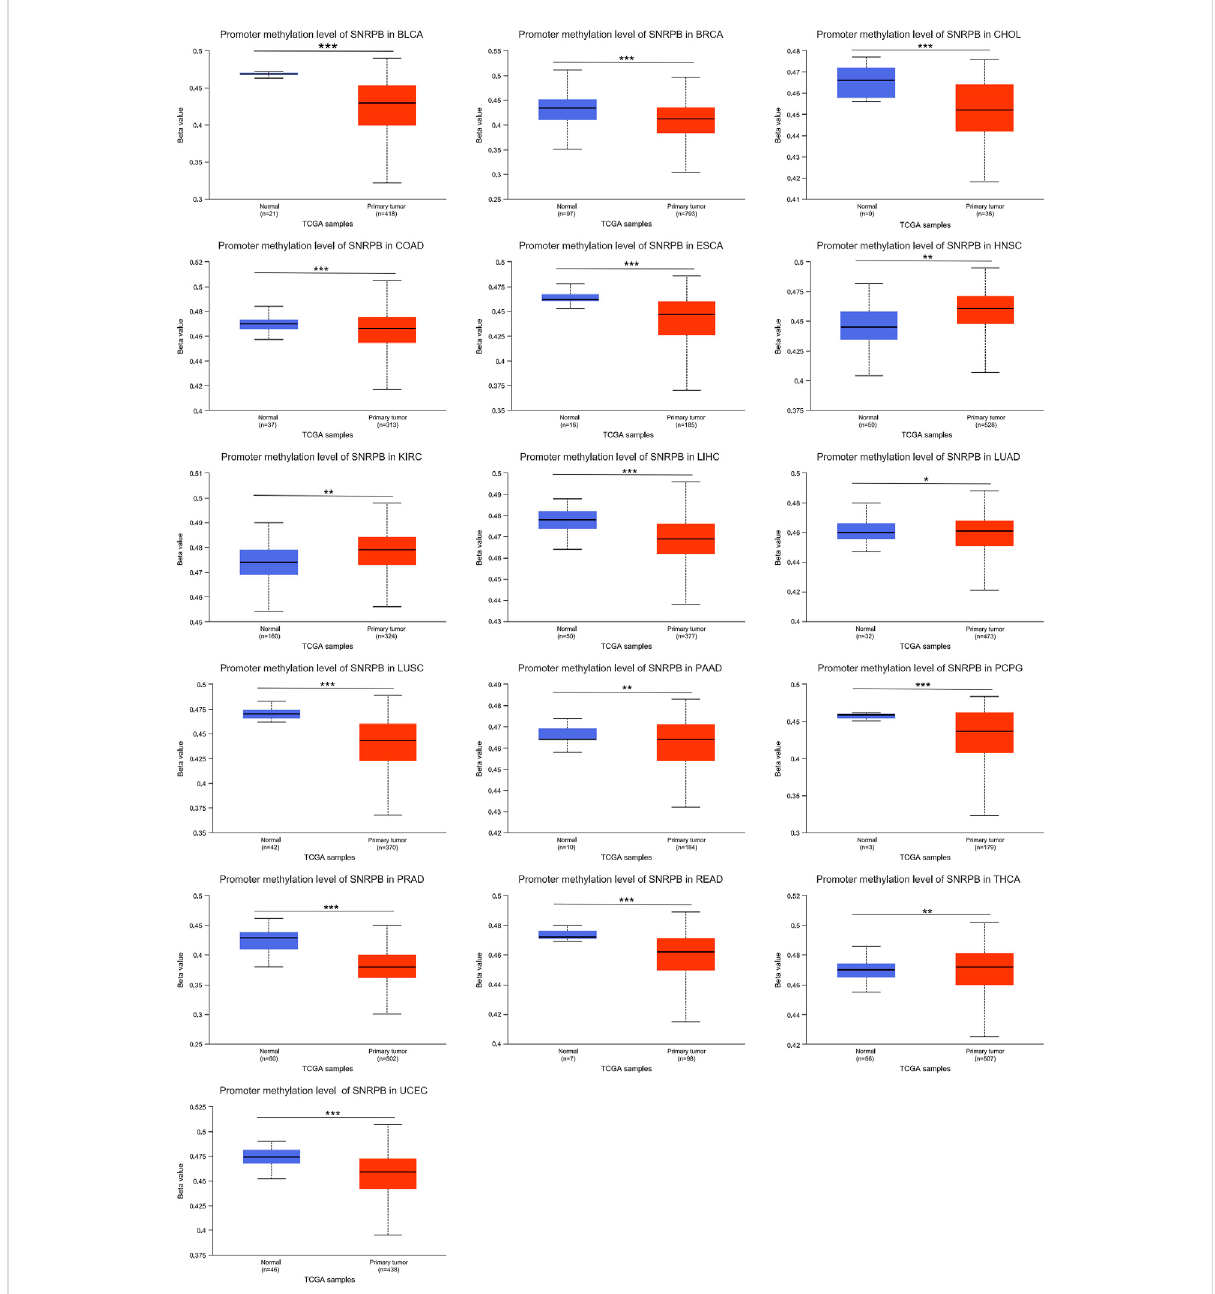
FIGURE 8 The promoter methylation level of SNRPB across tumors. *, p < 0.05; **, p < 0.01; ***, p <